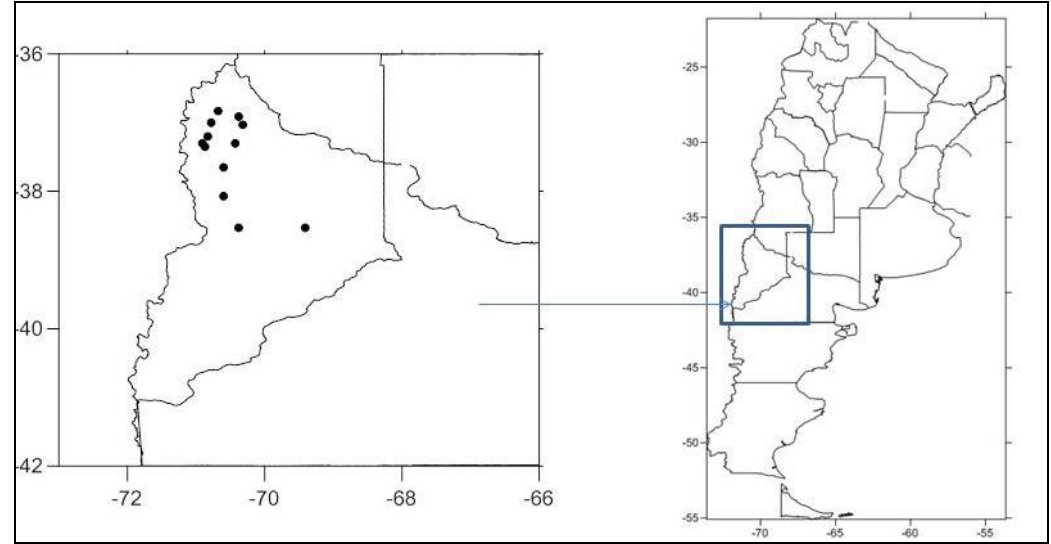
Figure 1. Area of study and location of the stations